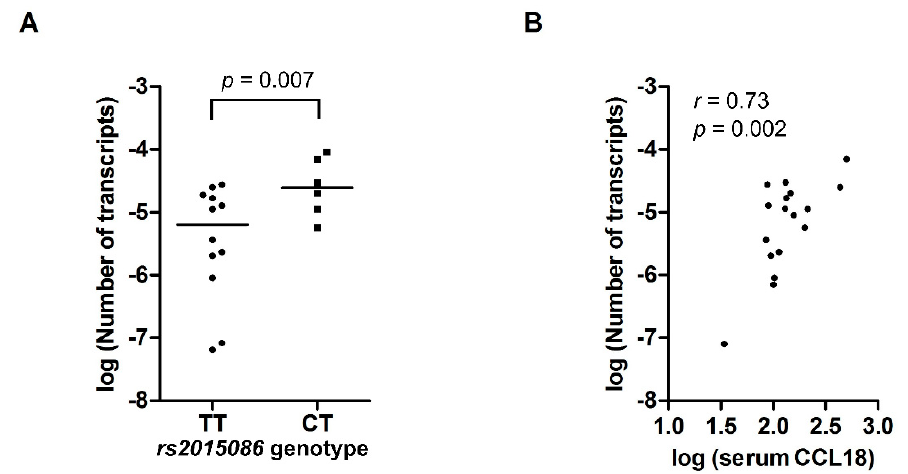
Figure 3. ( A ) mRNA expression of CCL18 in PBMCs from 18 healthy controls, expressed as the number of CCL18 transcripts per copy of β -actin, according to rs2015086 genotype. ( B ) Scatterplot showing the correlation between serum CCL18 levels and the number of CCL18 mRNA transcripts per copy of β -actin. Values on the X and Y-axis represent log-transformed values.